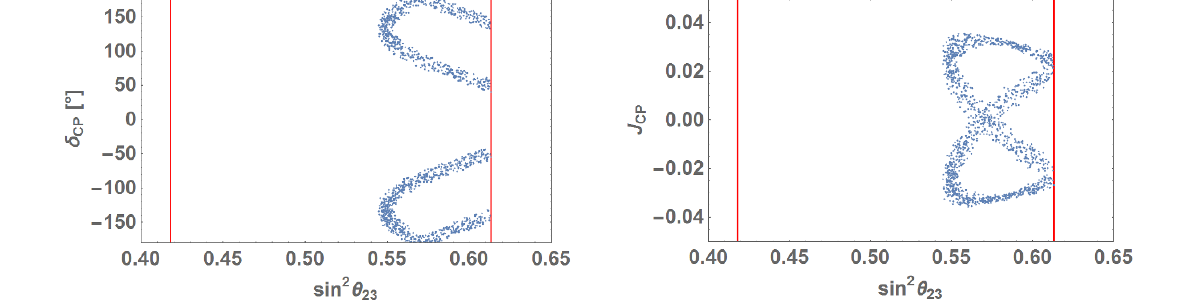
Figure 1 . The prediction of (cid:14) CP versus sin 2 (cid:18) 23 for NH in model I(a). The vertical red lines represent the upper and lower bounds of the experimental data with 3 (cid:27) .